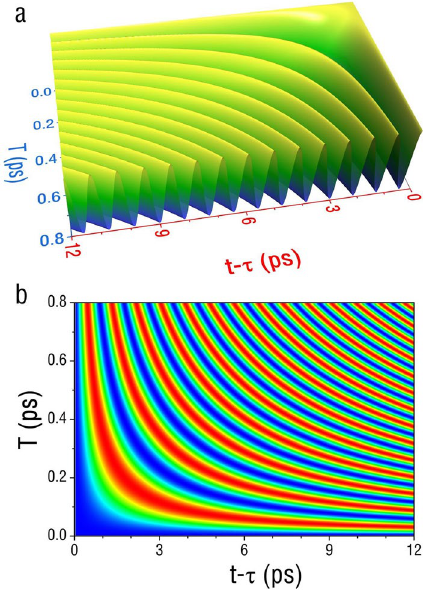
Figure 1. The mass oscillation behaviors of electron-neutrinos. ( a ) A 3D plot of the dependence of cos for the neutrino case, on T , the time interval between two neutrino beams, and t τ , the average time for two beams to reach a detector. ( b ) A contour plot of the same function. Both figures − illustrate the intensity oscillations from two interfering neutrino beams, reflecting the mass oscillations induced by the uncertainty in neutrino’s initial wave vector (cid:31) k . In this simulation, we consider electron-neutrino from reactors with relativistic mass-energy of 0.5 MeV, (cid:31) k of 10 10 m −1 and τ of 2.5 ms. The oscillation period appears τ to be on the order of sub-ps along the time axis of t −